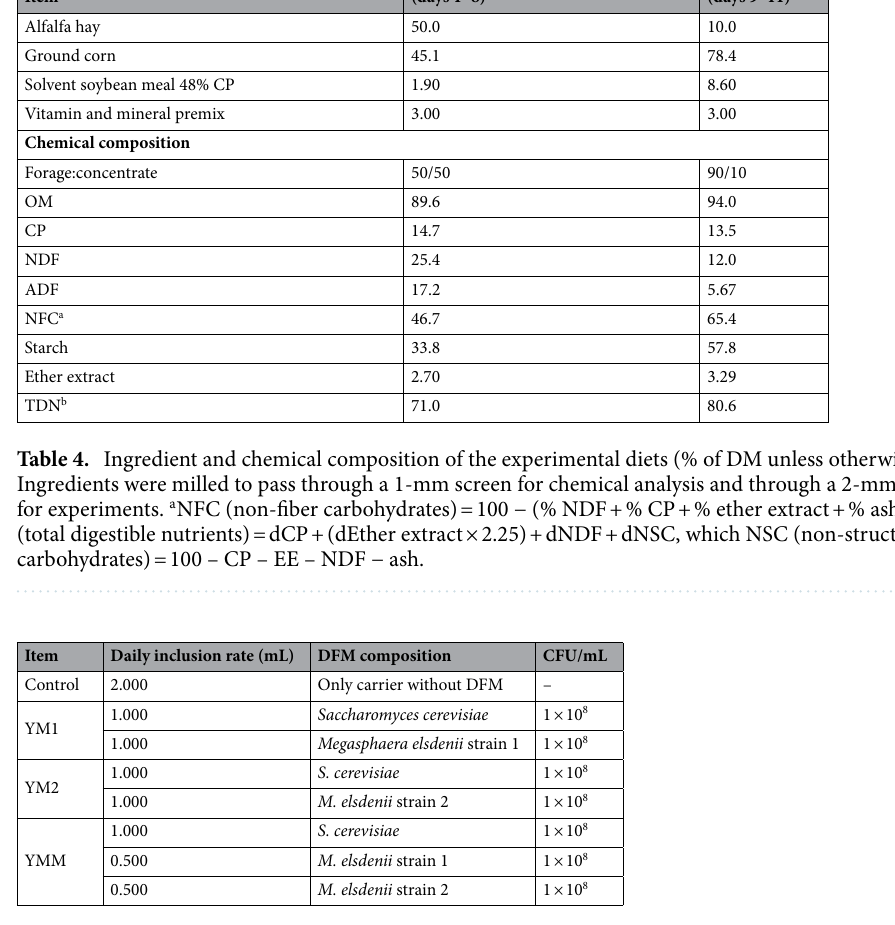
Table 5. Direct-fed microbials (DFM) composition and inclusion rate in the dual-flow continuous culture